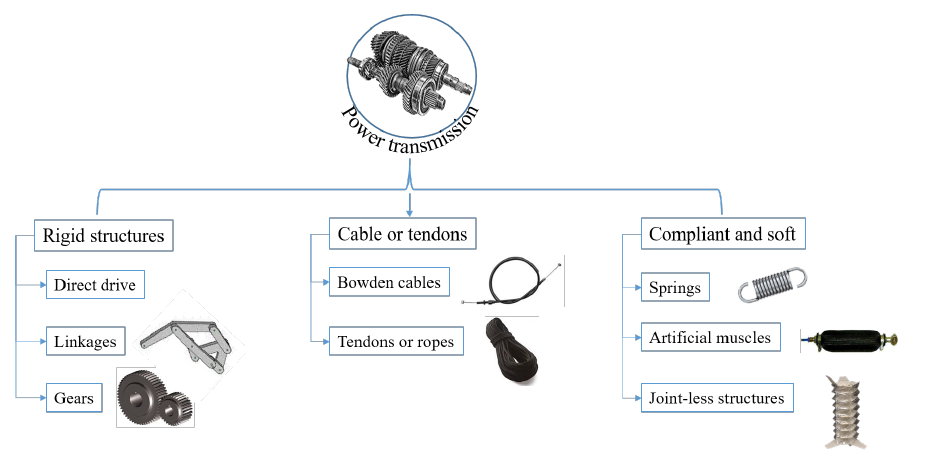
Figure 22. Different types of power transmission adopted in different